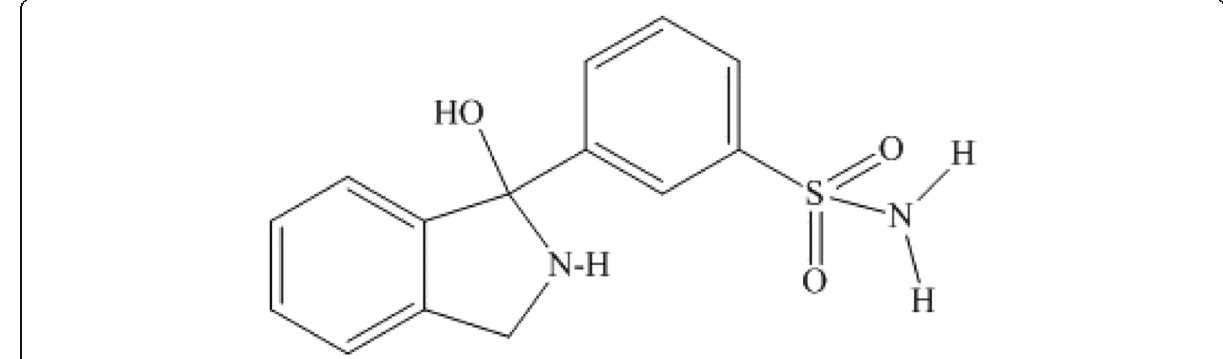
Fig. 1 Chemical structure of